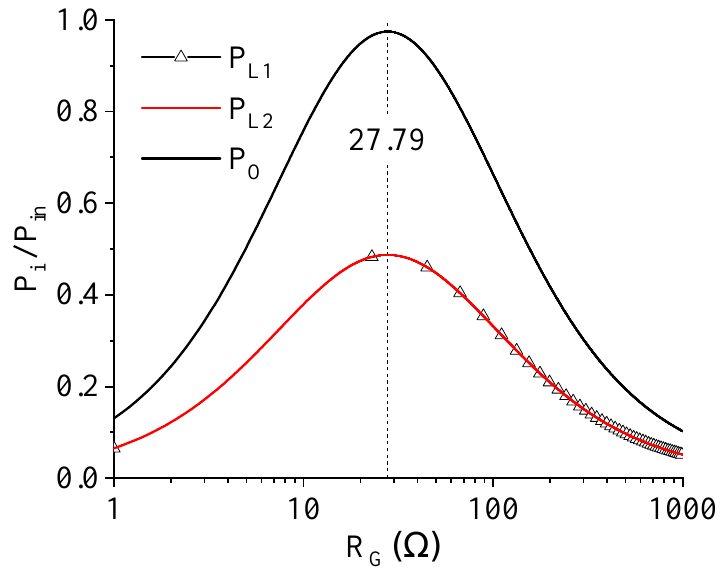
Figure 8. Case 1: output power calculated for Case 1 by varying the R G (i.e., the resistive part of the impedances of the